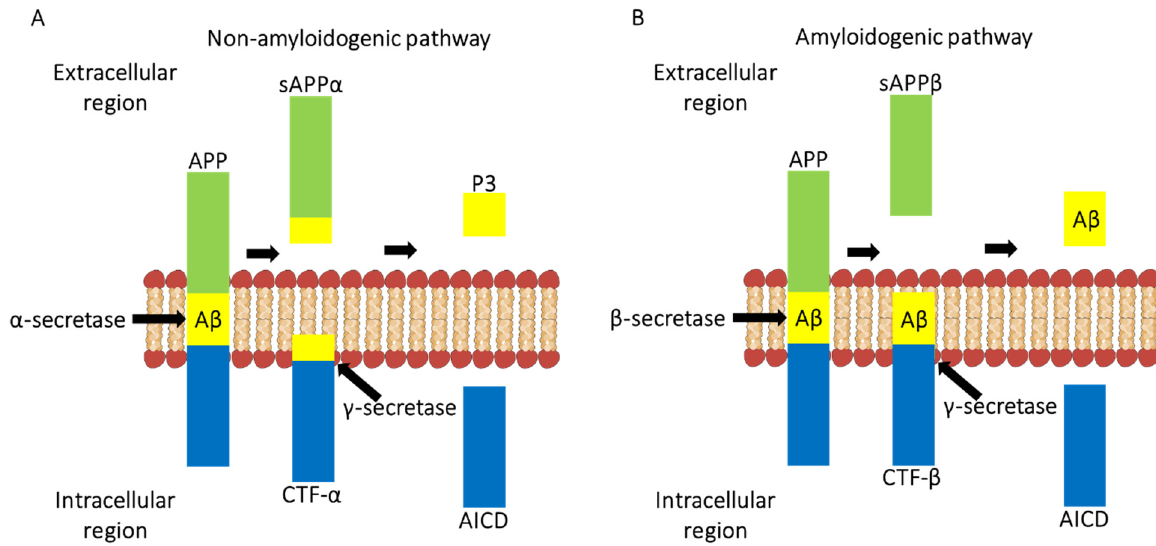
Figure 1. A schematic diagram showing how the amyloid precursor protein can be cleaved via non-amyloidogenic pathway ( A ) and amyloidogenic pathway ( B ). ( A ) In the non-amyloidogenic pathway, APP is hydrolysed by α -secretase which produces CTF- α and sAPP α . CTF- α is bound to the membrane, and sAPP α , a soluble ectodomain. CTF- α is then cleaved by γ -secretase within the membrane, allowing the release of P3 and APP intracellular domain (AICD). ( B ) In the amyloidogenic pathway, APP is hydrolysed by β -secretase 1 producing sAPP β and CTF- β . CTF- β is then cleaved within the membrane by γ -secretase yielding A β peptides- A β 1-40 or A β 1-42.